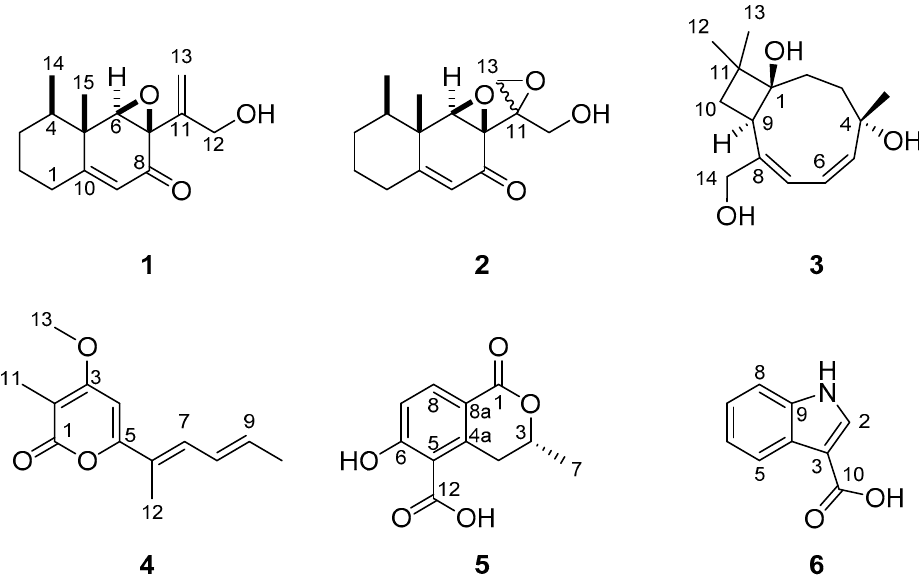
Figure 5. Chemical structures of secondary metabolites isolated from cultures of Stromatoneurospora phoenix . Phoenixilanes A – B ( 1 , 2 ) punctaporonin B ( 3 ), 8,9-dehydroxylarone ( 4 ), ( − )-( R )-6 hydroxy-3-